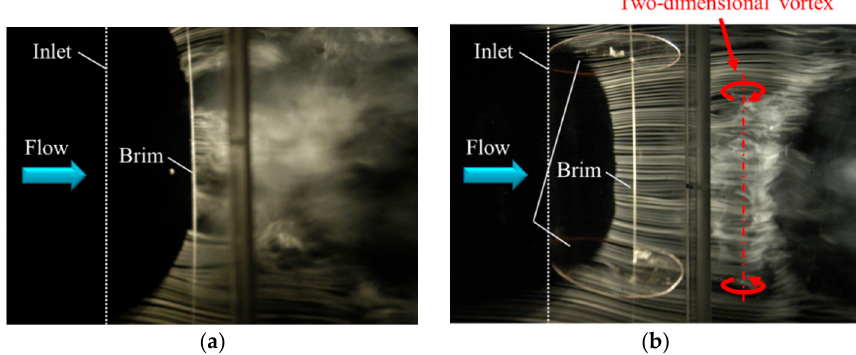
Figure 14. Flow visualization results: ( a ) Vortices generated by WLT Ci05 without the vortex stabilizing plates; ( b ) Vortices generated by WLT Ci05 with the type 2 vortex stabilizing plates.